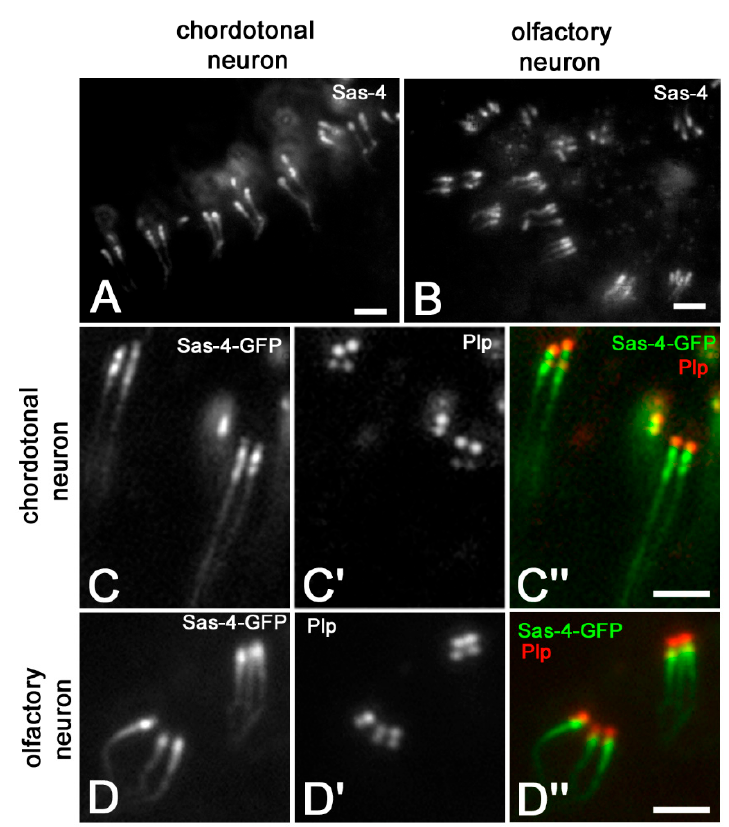
Figure 4. Localization of Sas-4 in wild-type chordotonal ( A ) and olfactory ( B ) neurons and Sas-4-GFP expression in chordotonal ( C , C (cid:48) , C” ) and olfactory ( D , D (cid:48) , D” ) neurons; centrioles are underlined by Plp localization. Scale bars: 5 µm.